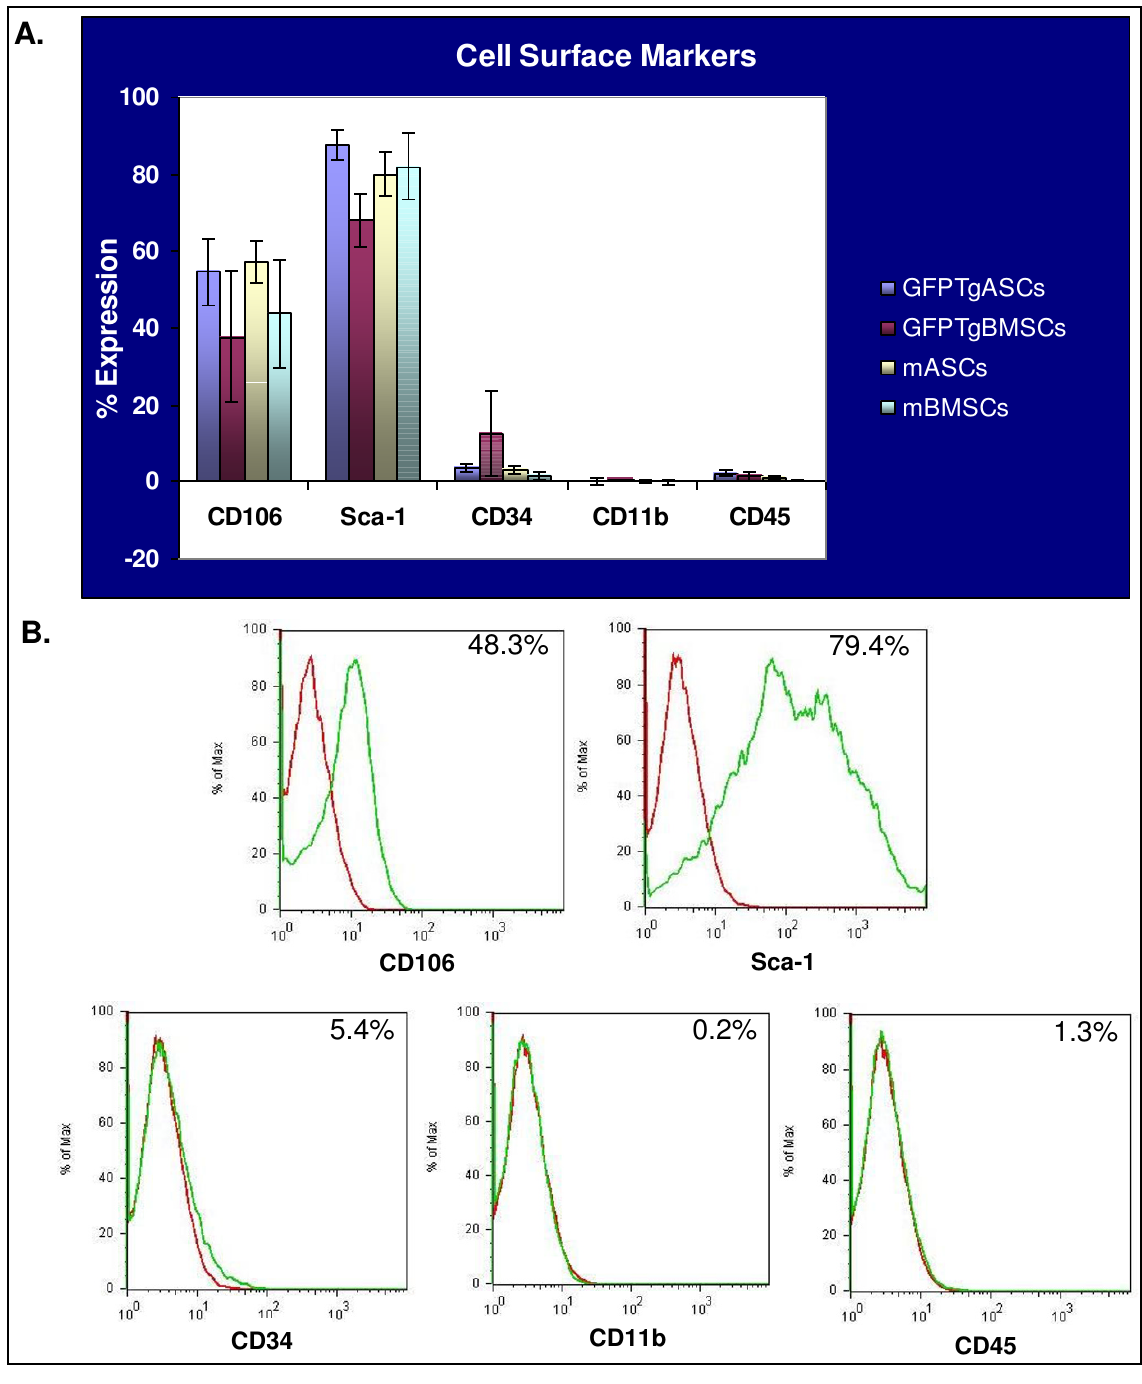
Figure 4 Immunophenotypic profile of mMSCs and GFPTgMSCs . A. Stem cells (P10 or lower) were incubated with antibodies for CD106, Sca-1, CD34, CD11b, or CD45 and assayed by FACS. Each antibody was tested individually and with isotype con- trols. B. Representative plots are shown with percentages corresponding to the average profile of all cell types. Red plot lines: isotype control; green plot: stem